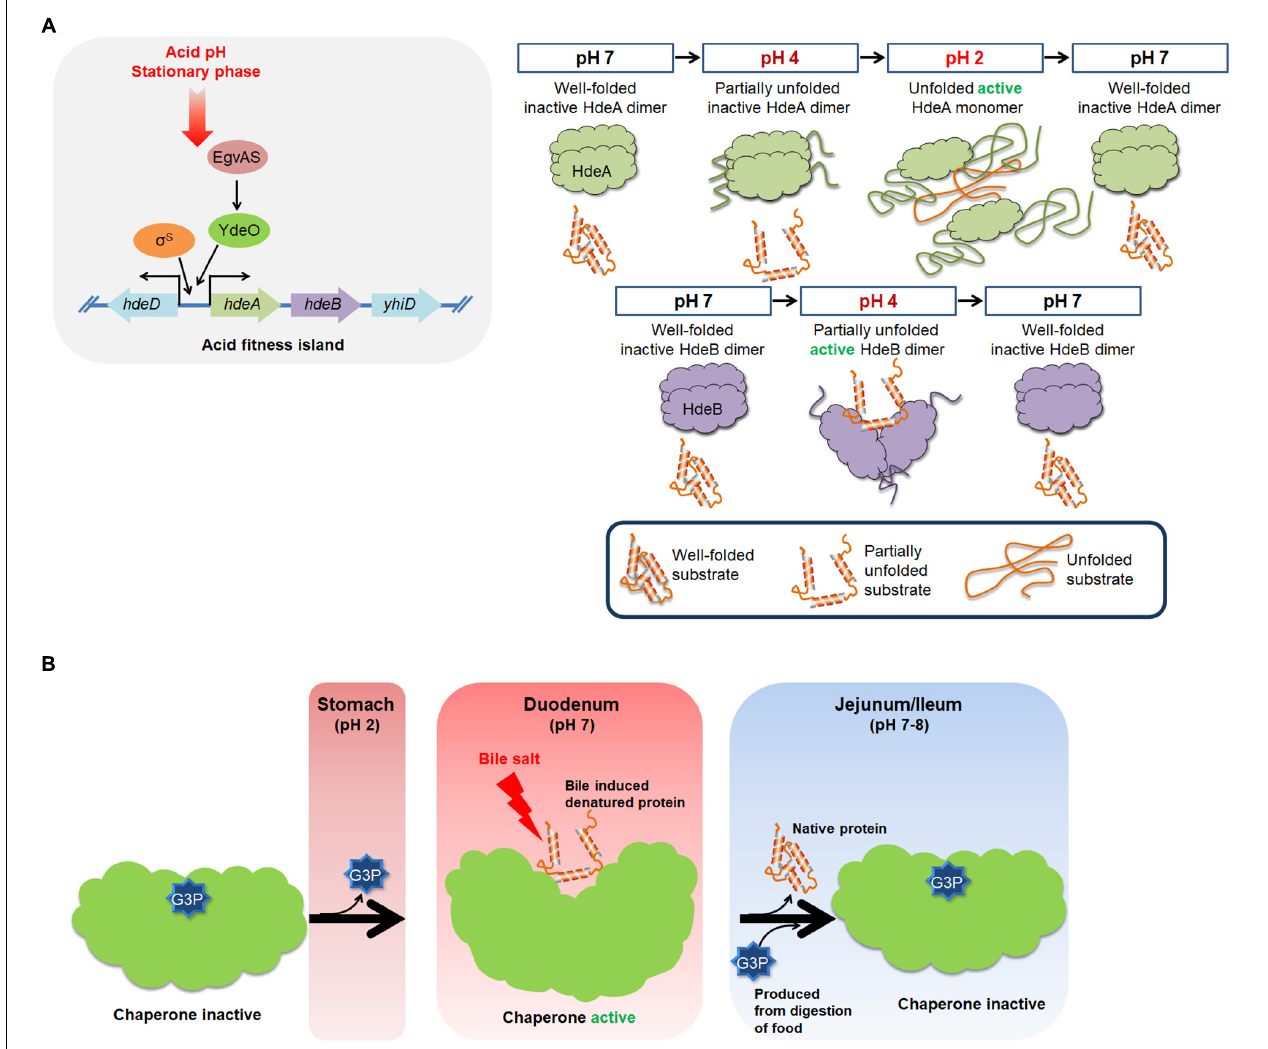
FIGURE 3 | An overview of the molecular mechanism of HdeA, HdeB, and UgpB. (A) Acidic pH levels and stationary phase can induce the expression of HdeA and HdeB, which act to protect a broad range of periplasmic proteins from acid-induced aggregation. At neutral pH, HdeA exists as a well-folded homodimer in an inactive state. At pH 2, the unfolded monomer form of HdeA can bind to the hydrophobic surfaces of denatured substrates and protect them from aggregation. HdeB also protects proteins from acid-induced aggregation. In contrast to HdeA, HdeB exhibits chaperone activity at pH 4 in a dimeric, partially unfolded form. (B) The E. coli periplasmic G3P-binding protein UgpB exhibits chaperone activity against bile salts. The chaperone activity of UgpB is evident only when G3P is stripped off of UgpB. Bacterial cells must pass through the acidic stomach and the bile-rich duodenum to reach the lower intestine where they colonize. Acidic pH levels in the stomach can unfold UgpB, resulting in the dissociation of G3P. Consequently, UgpB exerts chaperone activity to prevent bile salt-induced protein aggregation in the duodenum. Release of G3P exposes the core cleft region of UgpB, which functions as a chaperone active surface. An increase in the